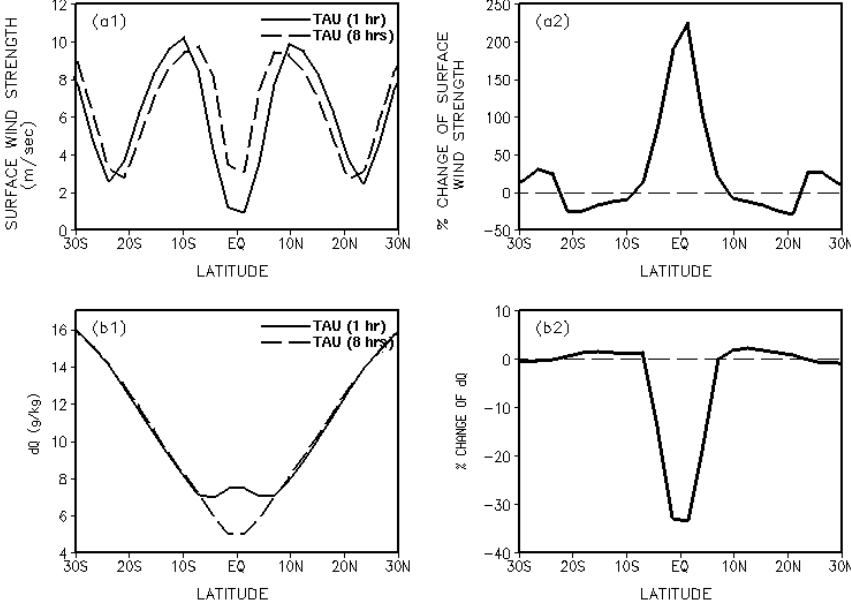
Fig. 11. Zonally averaged time mean quantity with TAU (1h), and TAU (8h), (a1) wind magnitude at lowest model level (m/s), (a2) per- centage change of magnitude of wind at the lowest model level of TAU (8h) with respect to TAU (1h), (b1) dq at lowest model level (g/kg), (b2) percentage change of dq for TAU (8h) with respect to TAU (1h). Notation: Percentage change of TAU (8h) with respect to TAU (1h)=[(TAU (8h) – TAU (1h))/TAU (1h) }· 100, dq= Q S ( T S ) –